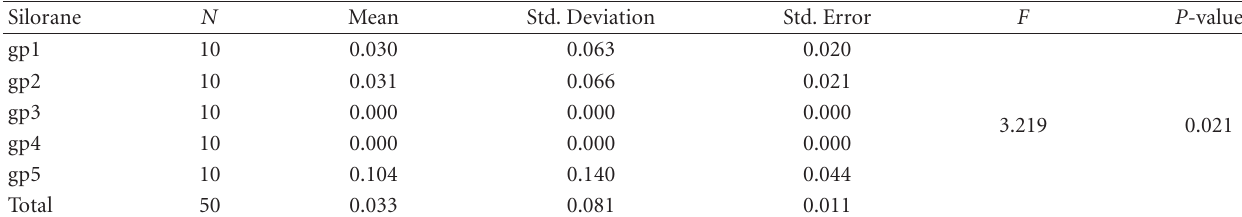
Table 3: One-way ANOVA of the results of dye penetration (in mm.) for Silorane with di ff erent cavity configurations. Silorane N